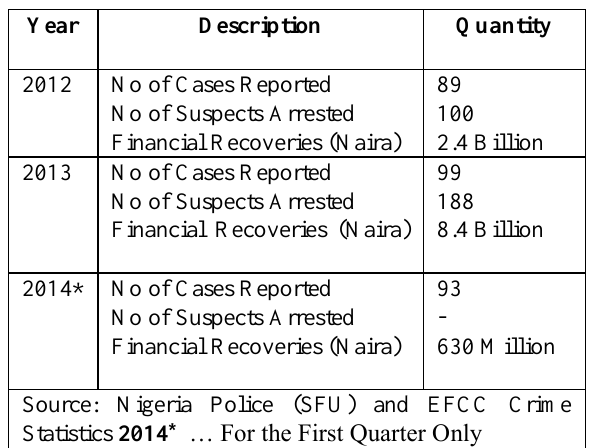
Table 2. Cyber Fraudulent Crime Statistics in Nigeria (EFCC/NFIU) - 2012 –